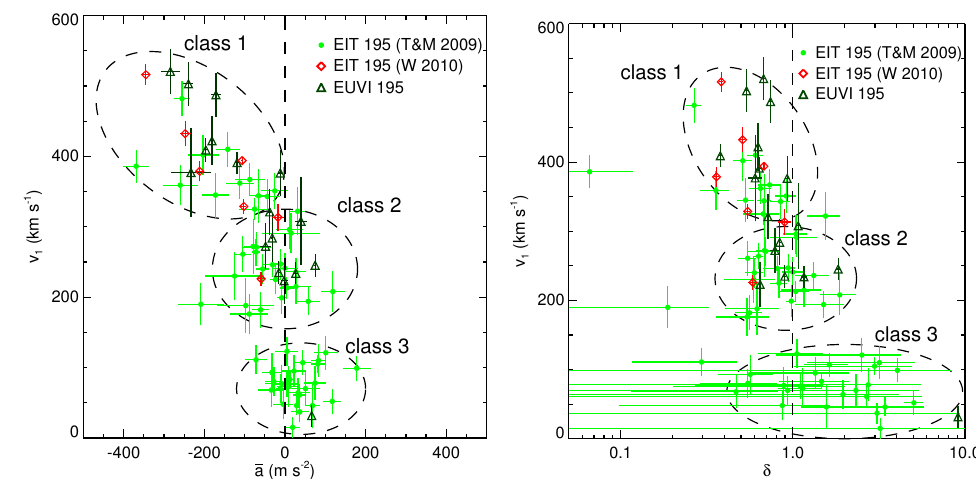
Figure 25: Kinematical characteristics of a larger coronal wave sample. Initial wave speed is plotted versus average acceleration ( left ) and power-law index ( right ) obtained from EIT and EUVI 195 ˚A data. Three distinct event classes are indicated. Image reproduced with permission from Warmuth and Mann (2011), copyright by